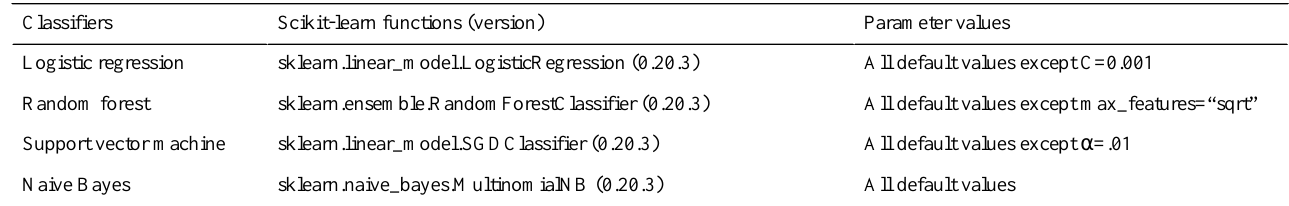
Table 4. Description of traditional classifiers and parameter settings used in the experiments (the same parameter settings were used for the following 3 targets: relevance, commercial, and